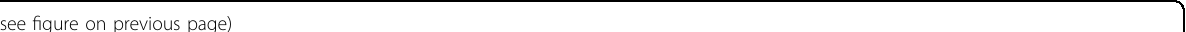
(see fi gure on previous page) Fig. 5 Protein levels of hippocampal (A, C, E, G, I) and frontal-cortex (B, D, F, H, J) mitochondrial respiration complexes following the administration of 0.75 mg/kg/day rotenone for 4/8 weeks. Results in % of control (vehicle) represent means ± SEM of 8 – 10 mice/group, each in duplicate. Results were analyzed by two-way ANOVA with treatment (±rotenone) and duration (4/8 weeks) as main factors: # values are of the treatment effects. Control values: Co I — hippocampus — 8773 ± 1275 a.u.; frontal-cortex — 13,500 ± 2400 a.u. Co II — hippocampus — 6937 ± 1390 a.u.; frontal-cortex — 13,916 ± 2590 a.u. Co III — hippocampus — 11,682 ± 961 a.u.; frontal-cortex 8100 ± 2700 a.u. Co IV — hippocampus 13,477 ± 1587 a.u.; frontal-cortex 4334 ± 845 a.u. Co V — hippocampus 13,773 ± 703 a.u.; frontal-cortex 29355 ± 1576 a.u. A Fisher ’ s LSD post hoc: *8 weeks rotenone vs. vehicle and vs. 4 weeks of rotenone, p < 0.00001. C Fisher ’ s LSD post hoc test: *8 weeks of rotenone vs. vehicle and vs. 4 weeks of rotenone, p < 0.007. D Fisher ’ s LSD post hoc test: *8 weeks of rotenone vs. vehicle, p = 0.01. E Fisher ’ s LSD post hoc test: *4 weeks of rotenone vs. vehicle and vs. 8 weeks of rotenone, p = 0.003; **8 weeks of rotenone vs. vehicle, p = 0.007. G Fisher ’ s LSD post hoc test: *8 weeks of rotenone vs. vehicle and vs. 4 weeks of rotenone, p ≤ 0.01. H Fisher ’ s LSD post hoc test: *4 weeks of rotenone vs. vehicle and vs. 8 weeks, p ≤ 0.004. I Fisher ’ s LSD post hoc test: *4 weeks of Rot. vs. vehicle and vs. 8 weeks of rotenone, p ≤ 0.00004. B , F , J . N.S. K , L . Representative blots of complexes I – V ( K — hippocampus; L — frontal-cortex) and Ponceau staining (total protein, for